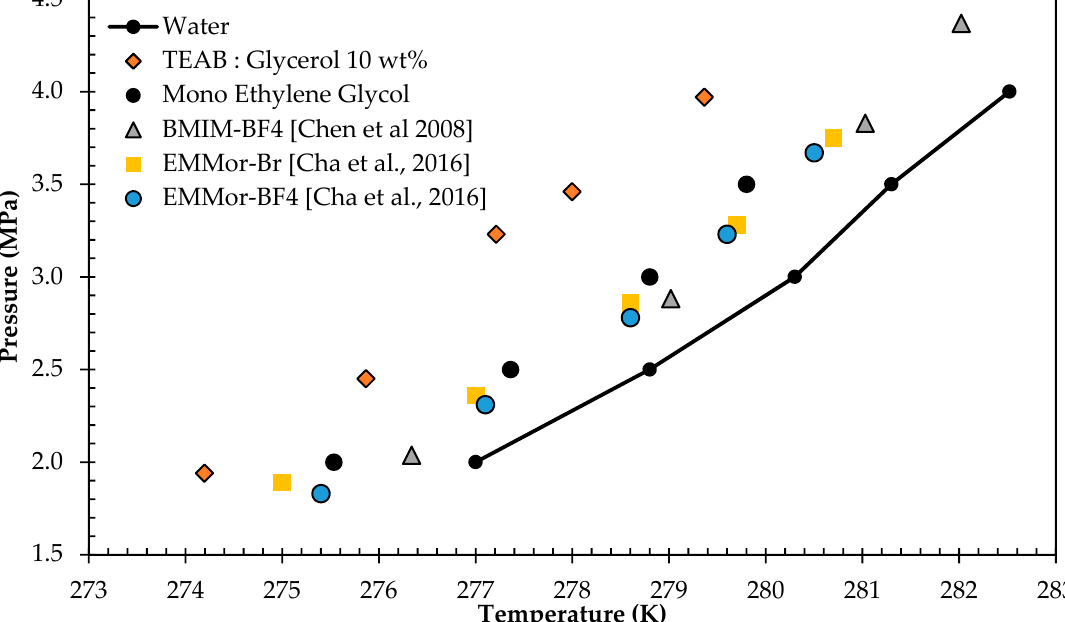
Figure 9. Comparison with conventional Thermodynamic Hydrate Inhibitors (THIs).